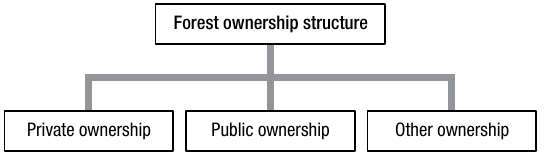
Fig. 3. Forest ownership structure. Source : Forestry Statistics (2009)